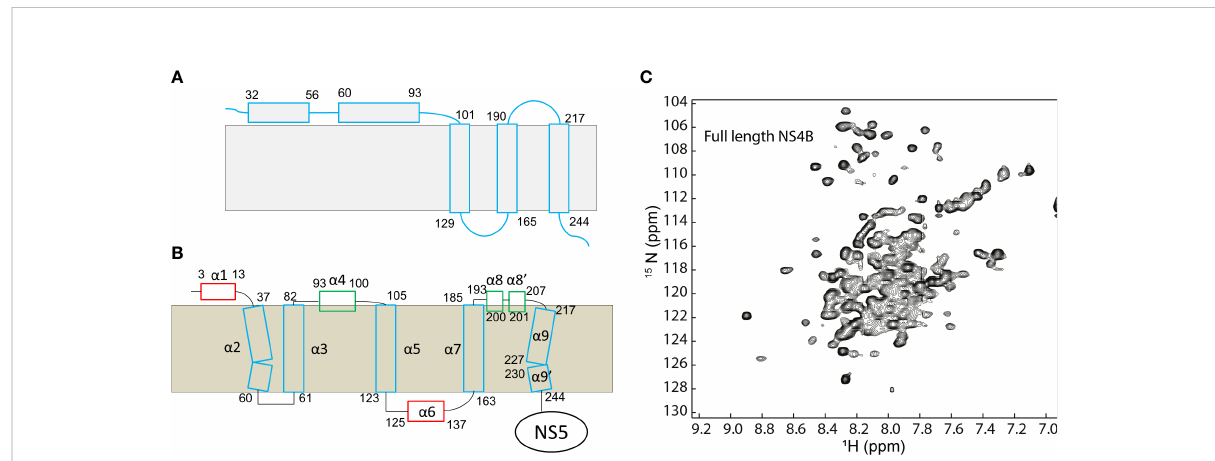
FIGURE 1 Topology of dengue NS4B protein. (A) Topology of NS4B determined using biochemical assays. (B) Topology of dengue NS4B in micelles determined using NMR spectroscopy. (C) The 1 H- 15 N- heteronuclear single quantum coherence spectroscopy (HSQC) spectrum of dengue 3 NS4B in LMPG micelles. This fi gure is obtained from the reference (Li et al., 2016) with